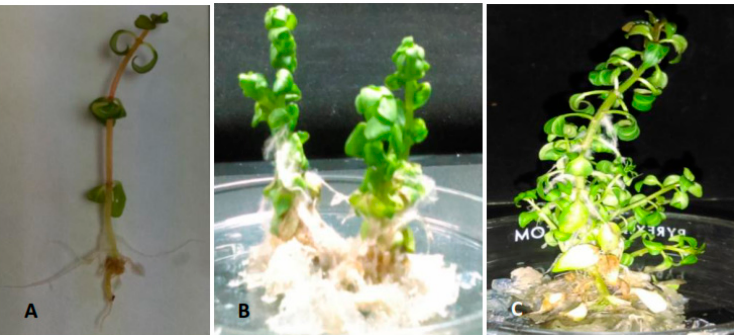
6 of 12 Figure 4. PCR amplification products of the rol B gen: lane (1) 1 Kb marker; lane (2) total DNA from A. rhizogenes ATCC 15834/pTDT strain; lane (3) empty; lane (4) total DNA from a wild type seedling L. racemosa ; lane (5) empty; lane (6) total DNA of regenerated plantlet LRT 2.3; lane (7) empty; lane (8) total DNA of regenerated plantlet LRT 6.4; lane (9) empty and lane (10) negative control (water). 2.4. Statistical Analysis of the Morphological Characteristics The plantlets regenerated from the hairy root lines LRT 2.3 and LRT 6.4 showed the morphological characteristics typical of ‘hairy root syndrome’, with short internodes, a greater number of leaves, and plagiotropic adventitious roots (Figure 5). Such character- istics, which are not present in wild-type (WT) seedlings and plants, have been previously reported in plantlets regenerated from hairy roots derived from several plant species. These characteristics have been associated with the expression of the rol A , B , C , and D